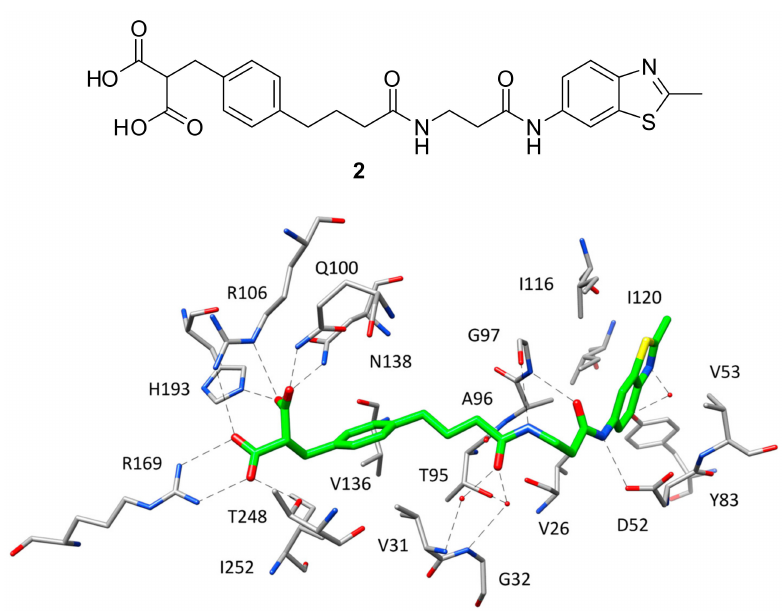
Figure 2. Chemical structure of 2 and X-ray structure of h LDH5 in complex with 2 (PDB code 4AJP). The active site residues interacting with the inhibitor are shown and the ligand–protein H-bonds are